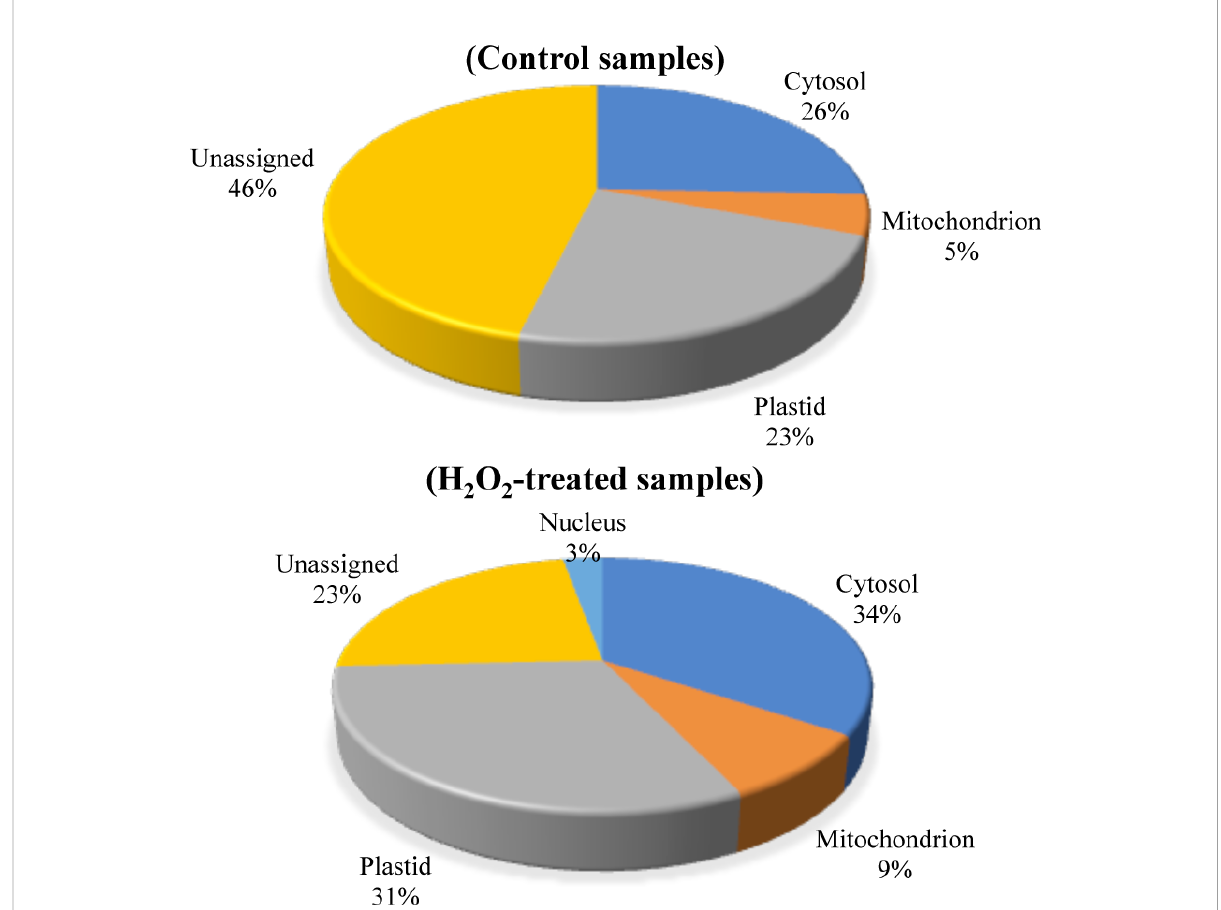
FIGURE 4 Predicted sub-cellular localization of the carbonylated proteins. The subcellular localization of the carbonylated proteins in the control samples and the H 2 O 2 -treated samples were compared by using the Subcellular Proteomic Database SUBA. (A) control plant samples. (B) H 2 O 2 -treated plant